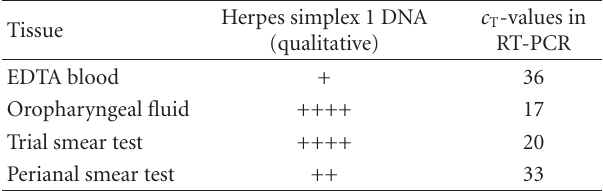
Table 1: Results of the semiquantitative PCR performed two days before death. The c T -value (cycle threshold) specifies the number of cycles till the beginning of exponential phase when sample fluorescence exceeds background fluorescence for the first time.